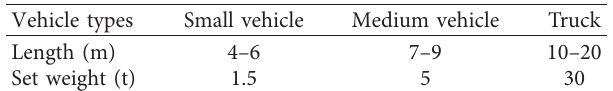
Table 3: Vehicle types.